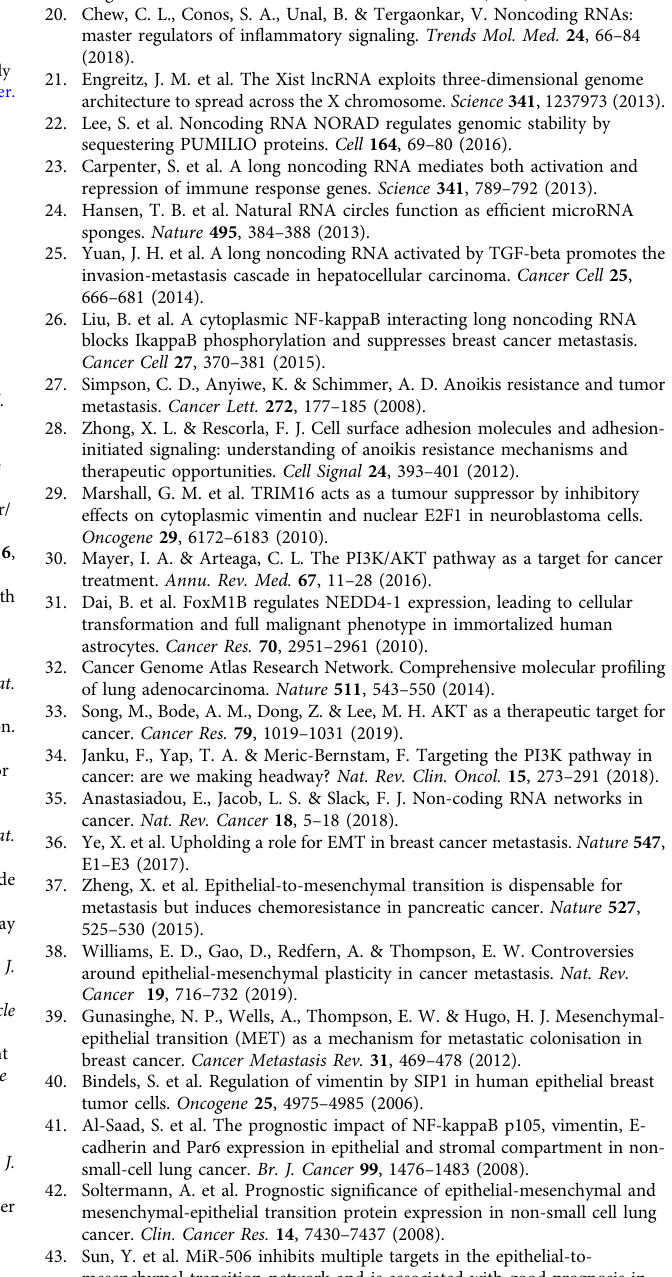
Fig. 7 Blocking Vimentin degradation is crucial for LAD metastasis. a Representative images and quanti fi cation of invading cells in fi ve random fi elds of Matrigel-coated transwell assay. b Representative images of H&E staining display a clear boundary and irregular invasive front between the dermal tissue and tumor tissue in the subcutaneous tumors ( n = 5 per group), respectively, xenografted with the indicated cells. Black arrows mark the direction of tumor invasion with invasive front marked by dashed line. c Representative bioluminescent images of systemic metastasis in nude mice ( n = 5 per group) intracardially injected with VAL-overexpressing A549 cells silenced with Vimentin or corresponding vector-control cells. d Representative images of metastatic bone lesions in nude mice ( n = 5 per group) intracardially injected with A549-VAL cells silenced with Vimentin or control scramble were evaluated by micro-CT imaging and H&E staining. e The effect of overexpressing Vimentin, silencing Trim16, or restoring an shRNA-resistant mutant VAL or wild-type VAL on cell invasion in A549-myr-AKT1 or H1975 cells pre-silenced for VAL. f , g Expression of VAL is associated with activated AKT (Ser-473 phosphorylated AKT1), activated STAT3 (Ser-727 phosphorylated STAT3) and Vimentin levels in LAD tissue. Two representative cases are shown. Scale bar: 100 μ m ( a , b , d , e ), 200 μ m ( f ). Scatter dot plots represent the means± SD. Statistical analyses were performed by two-way ANOVA multiple comparison analysis ( e , g ) and two-tailed unpaired Student ’ s t test ( a ). Source data are provided as a Source Data fi